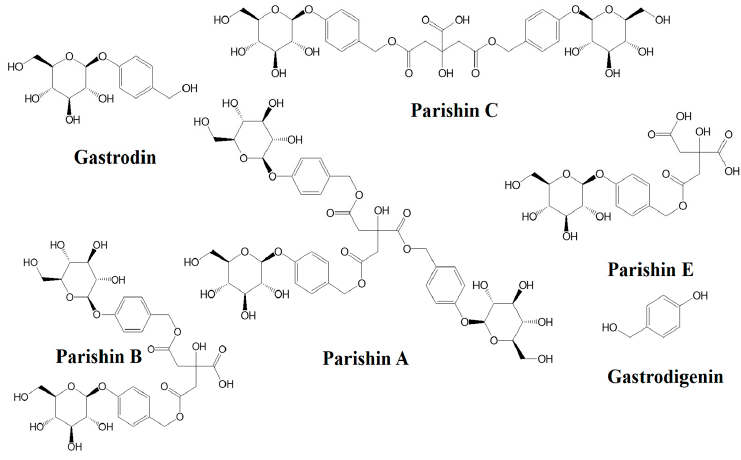
Figure 1. Chemical structures of the gastrodin-type components.